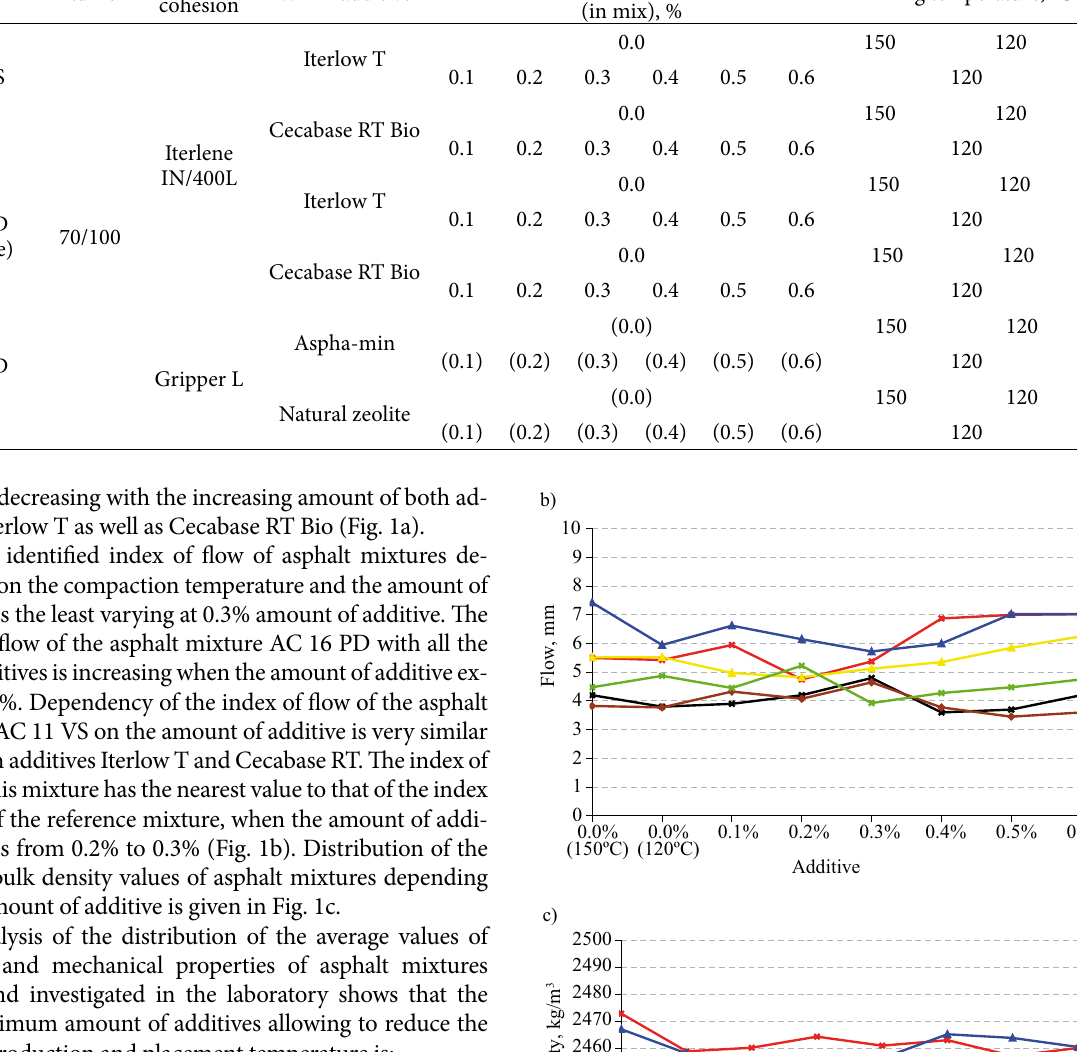
Table 2. Systemized data of experimental laboratory research of asphalt mixtures. Asphalt Additive for Bitumen WMA additive mixture cohesion